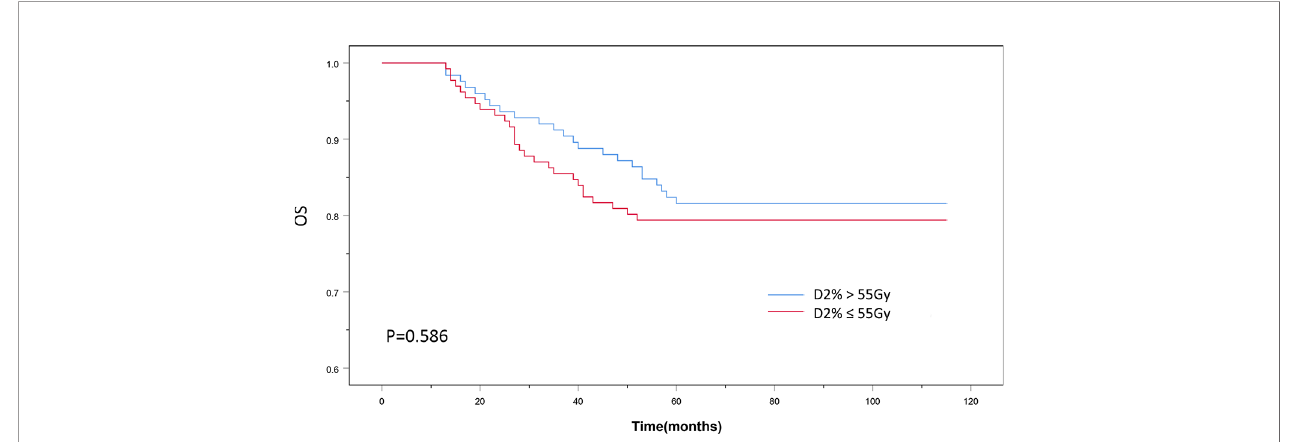
FIGURE 2 | The 5-year overall survival outcomes of D2% >55Gy and D2% ≤ 55Gy groups treated with intensity-modulated radiotherapy. P < 0.05 was considered statistically signi fi